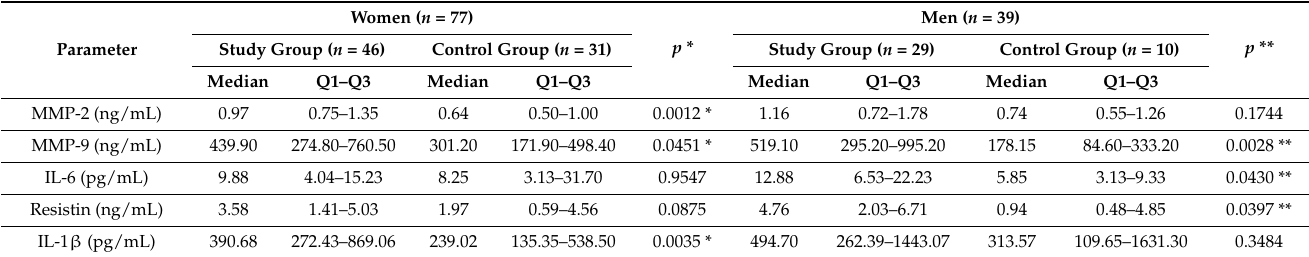
Table 2. Comparison of the concentration of selected proinflammatory cytokines and adipokines between women and men from the study and control